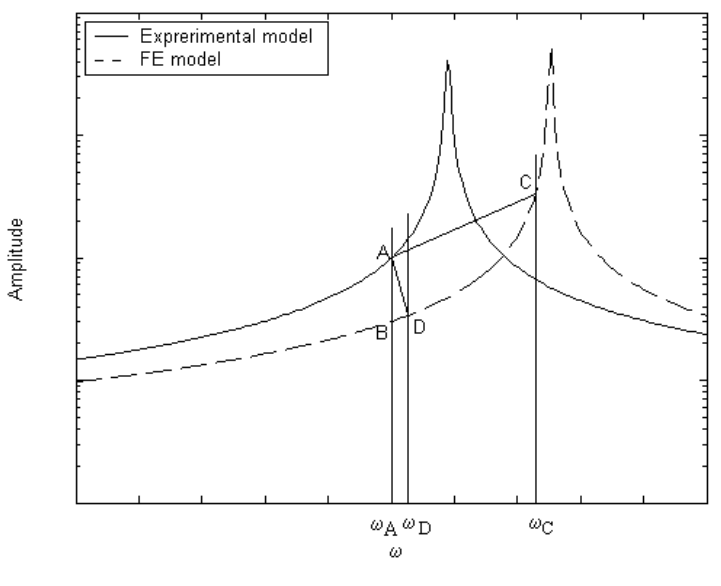
Fig. 1. Different error